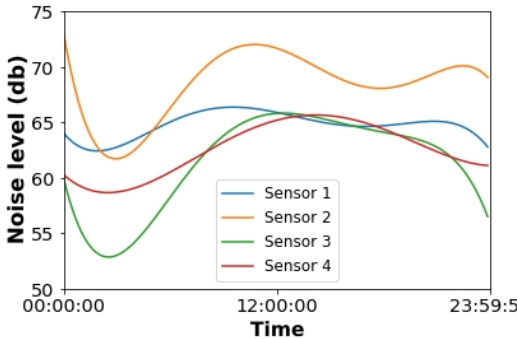
Figure 9. Polynomial curve fitting of the levels of noise for each